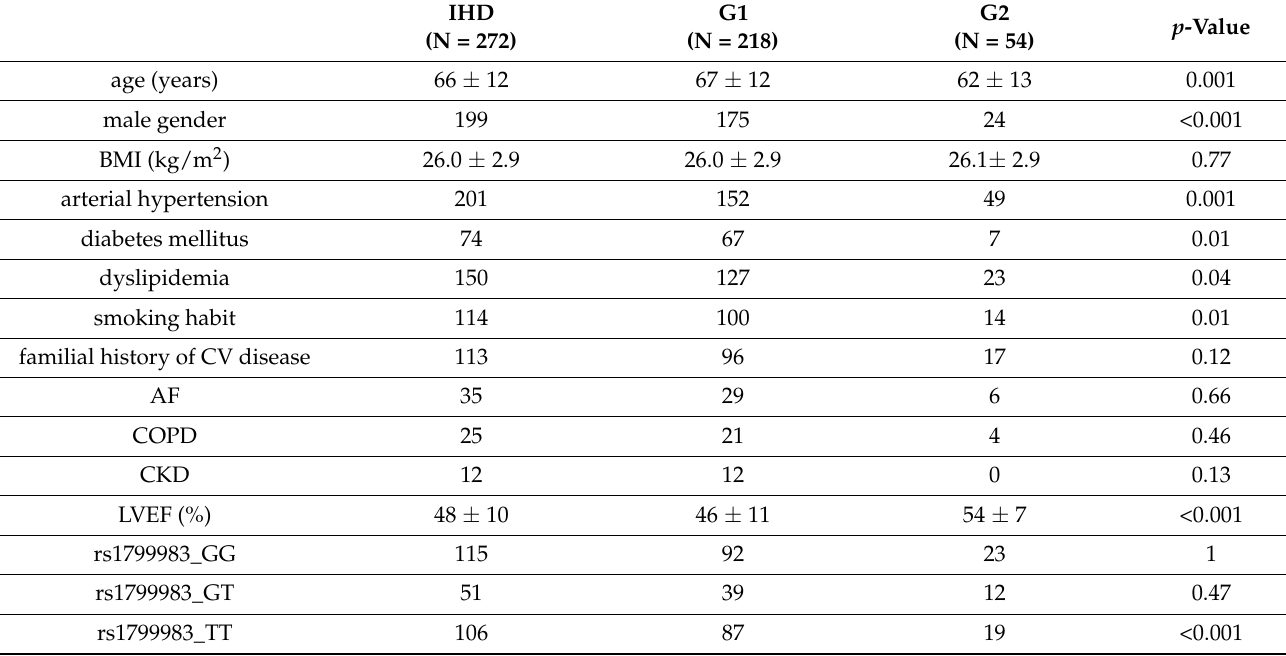
Table 2. Baseline features of the ischemic population, and differences between CAD (G1) and CMD (G2)